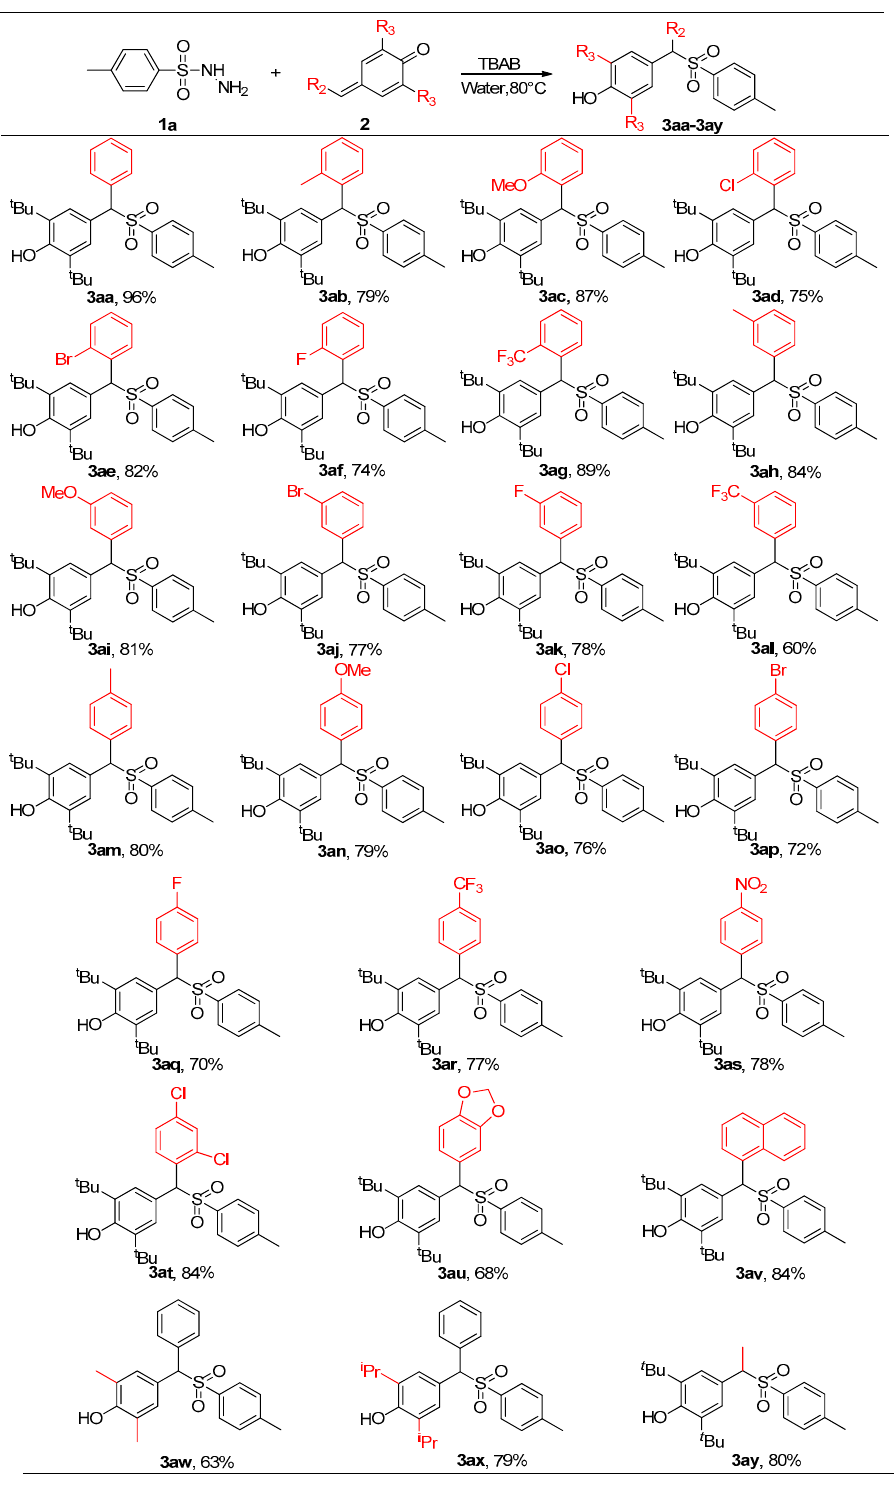
Figure 2. Tetrabutylammonium bromide (TBAB)-catalyzed 1,6-conjugate sulfonylation for synthesis